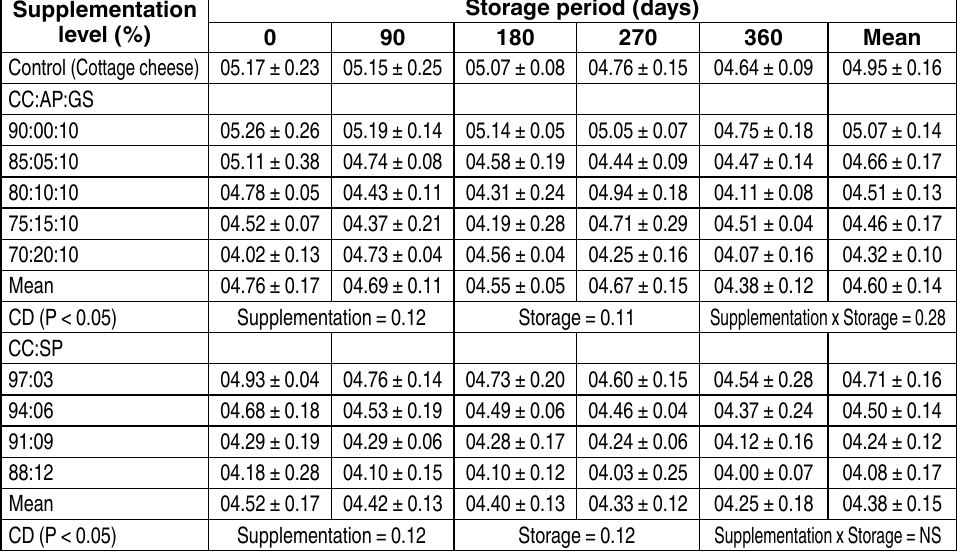
Table 7. Effect of supplementation and storage on pH of value-added churpe products (balls and strips) Supplementation level (%)